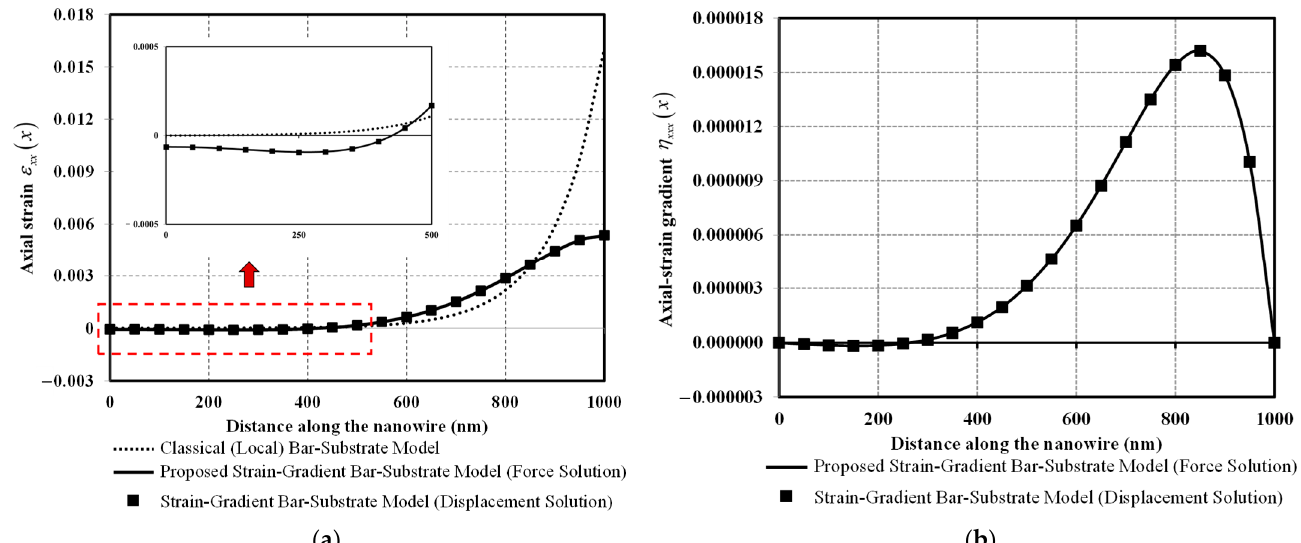
Figure 7. Axial strain and axial-strain gradient versus distance along the nanowire: ( a ) Axial strain; ( b ) Axial-strain gradient.